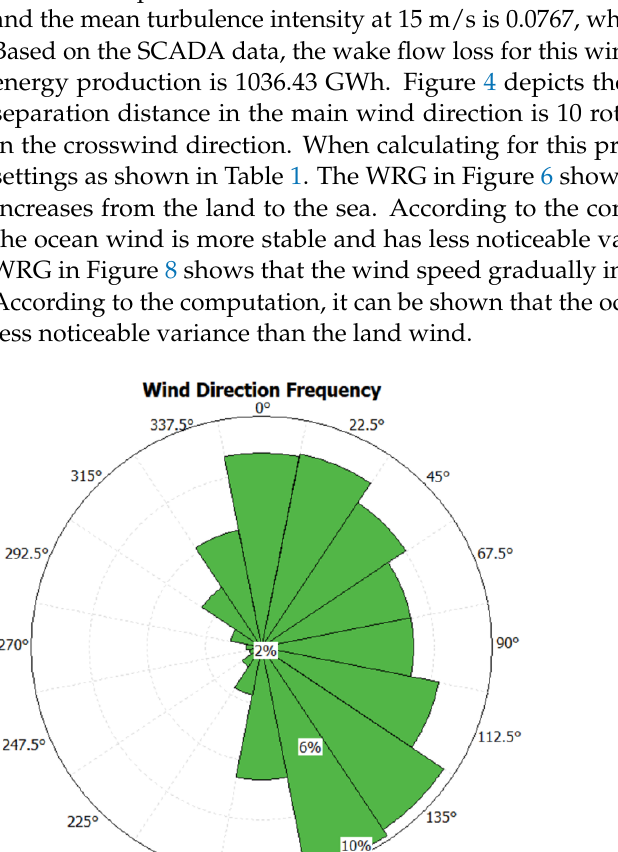
Figure 8. Resource diagram for position of Yangkou wind farm.